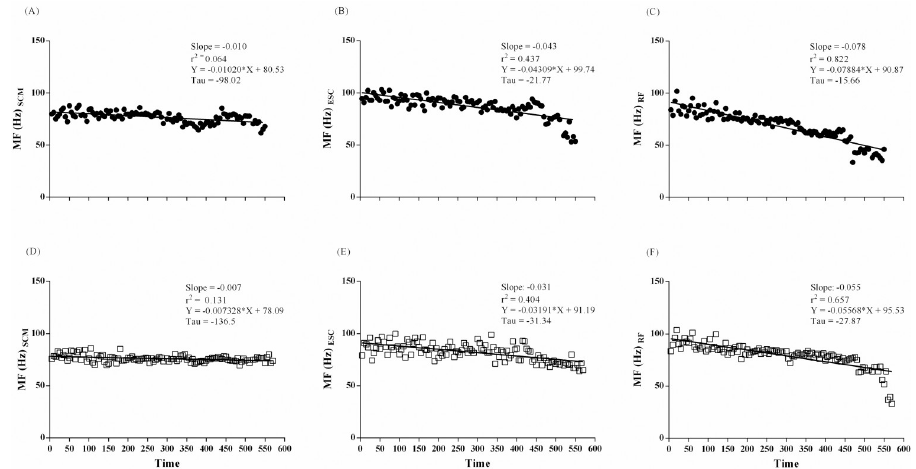
Fig 3. sEMG frequency median of SCM (A and D), ESC (B and E), and RF (C and F) muscles on ISWT, in Asthma- group (close circles) on upper panel and control group (open square) on the lower panel.